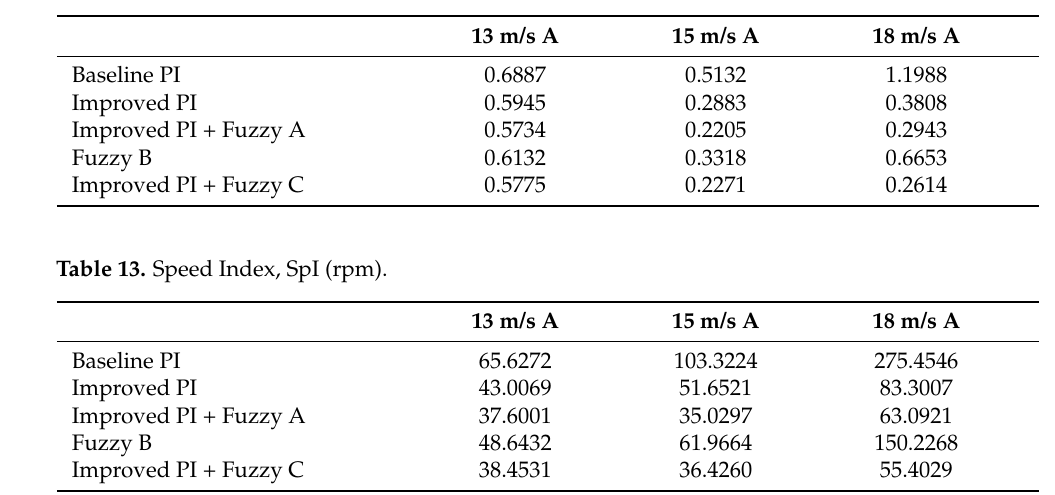
Table 12. Generation Index, GI (MW).